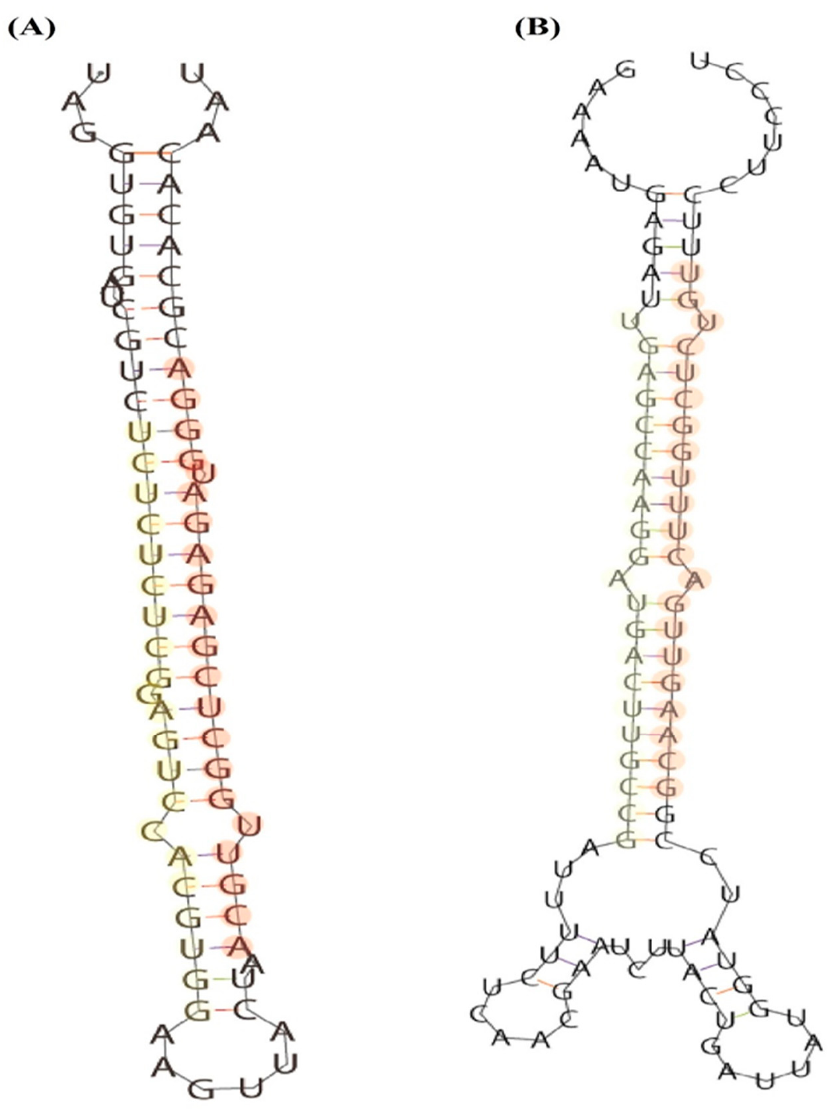
Figure 4. Predicted secondary structures of representative novel miRNAs in the flower buds of cabbage. ( A ) bol-miR0001. ( B ) bol-miR0023.